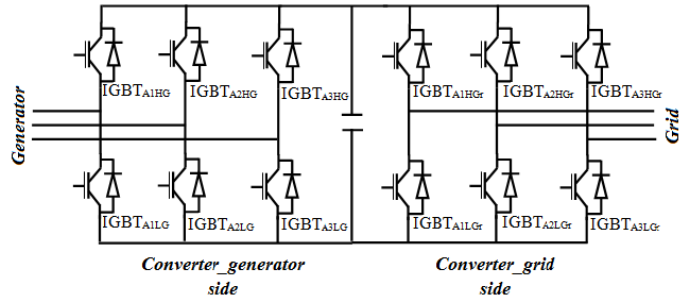
Figure 8. Converter topology